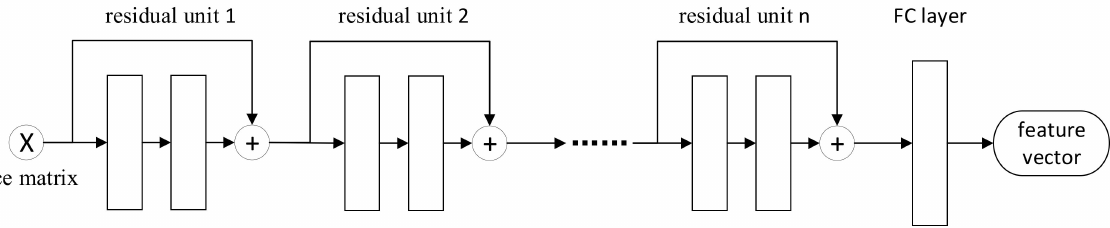
Figure 4. Complete residual network of face recognition. The primitive face information is processed by several residual unit to get the feature